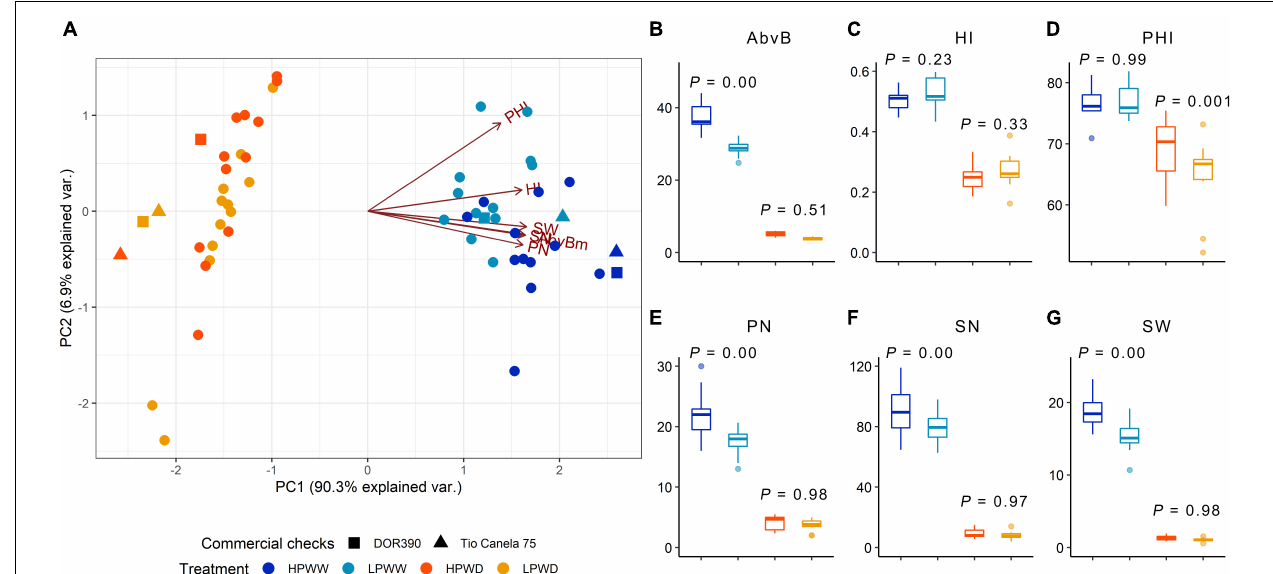
FIGURE 1 | (A) Principal component analysis of yield parameters; pod harvest index (PHI), harvest index (HI), seed weight (SW, g), seed number (SN), aboveground biomass (AbvB, g), and pod number (PN) for 12 common bean genotypes under treatments of high phosphorus well-watered (HPWW; blue), low phosphorus well-watered (LPWW; light blue), high phosphorus water deficit (HPWD; orange), and low phosphorus water deficit (LPWD; yellow-orange). Commercial checks are illustrated by square and triangle shapes. (B) Aboveground biomass, (C) harvest index (HI), (D) pod harvest index (PHI), (E) pod number (PN), (F) seed number (SN), (G) seed weight (SW, g) for 12 common bean genotypes under treatments of high phosphorus well-watered (HPWW; blue), low phosphorus well-watered (LPWW; light blue), high phosphorus water deficit (HPWD; orange), and low phosphorus water deficit (LPWD; yellow-orange).